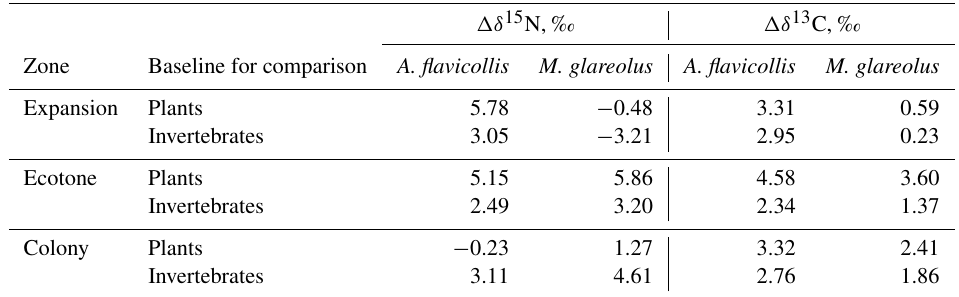
Table 4. Nitrogen ( (cid:49)δ 15 N) and carbon ( (cid:49)δ 13 C) trophic fractionation between Apodemus flavicollis and Myodes glareolus and their possible food sources in the Juodkrant˙e great cormorant